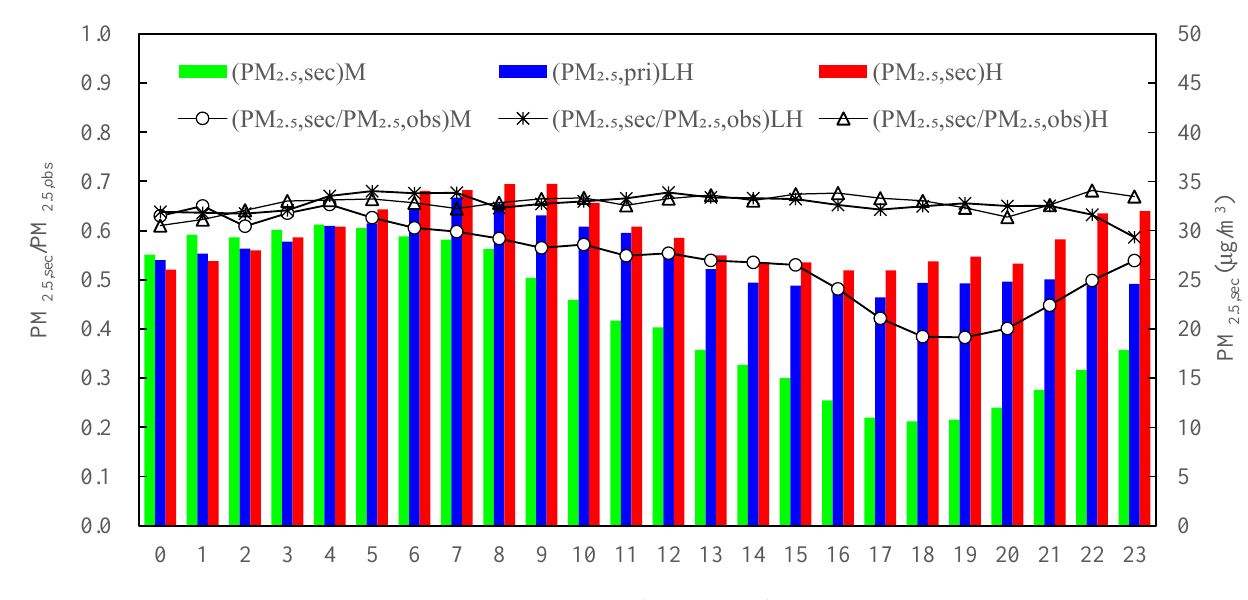
Figure 7. Diurnal variations in estimated secondary PM 2.5 mass concentrations and ratio of secondary to observed PM 2.5 mass concentrations at different photochemical activity levels in the summertime 2020 in Tianjin, China.